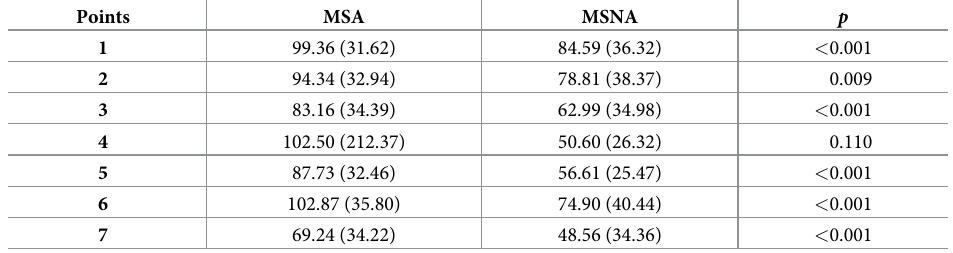
69.24 (34.22) 48.56 (34.36) < 0.001 � Values presented as mean (standard deviation). MSA: Affected upper limb by lymphedema. MSNA: Unaffected upper limb by